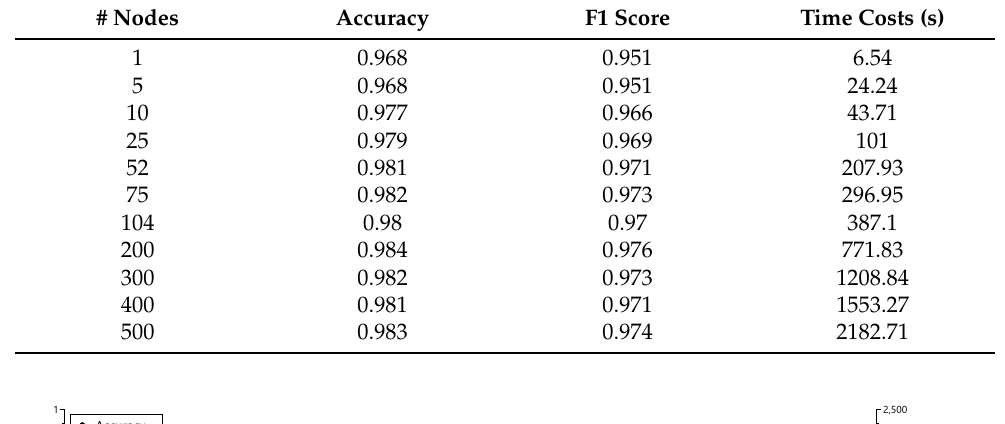
Table 6. The hyperparameter optimization result for a single hidden layer.